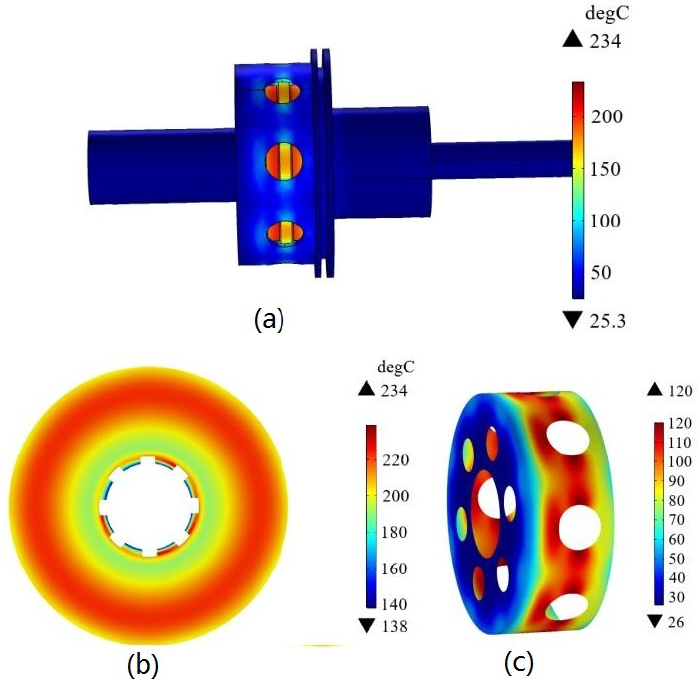
Figure 14. Temperature fi eld simulation results (engagement pressure rise time is 10 s). ( a ) Overall temperature fi eld ( b ) Friction plate ( c ) Clutch housing.